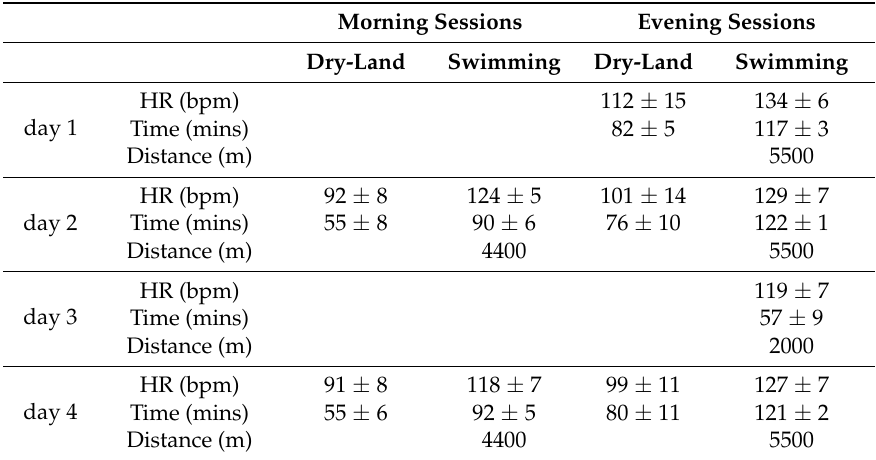
Table 4. Summary of exercise sessions during the five-day experimental period.